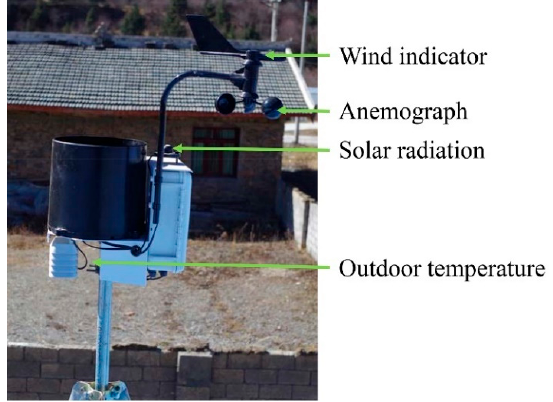
Energies 2019 , 12 , x FOR PEER REVIEW